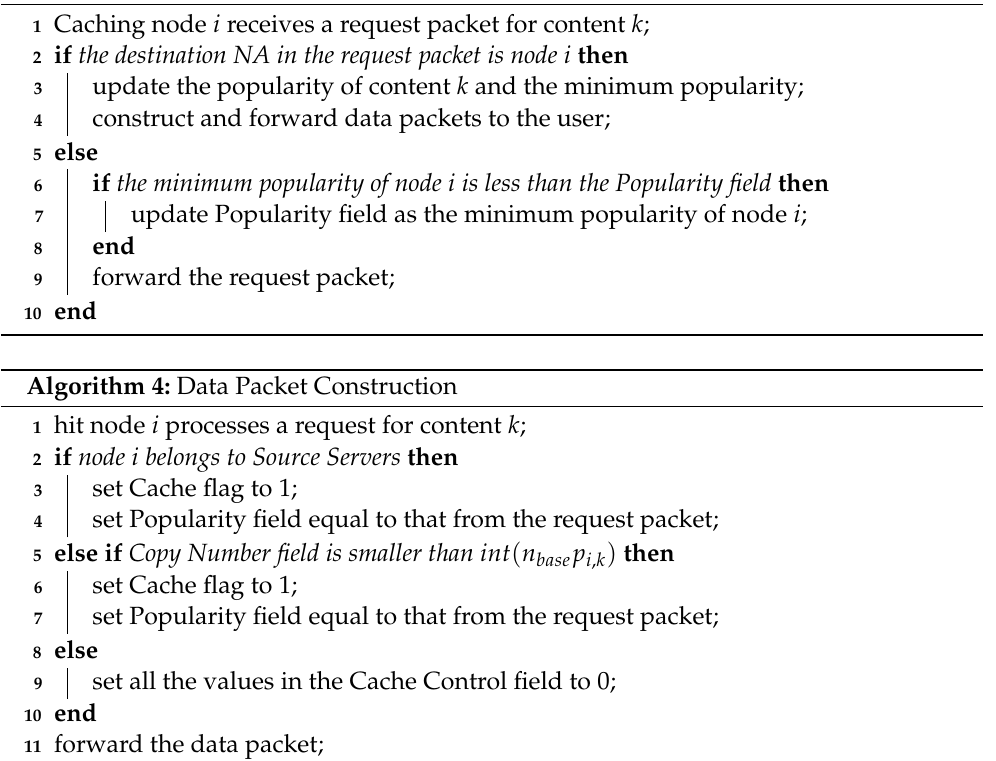
Algorithm 3: Request Packet Forwarding Process